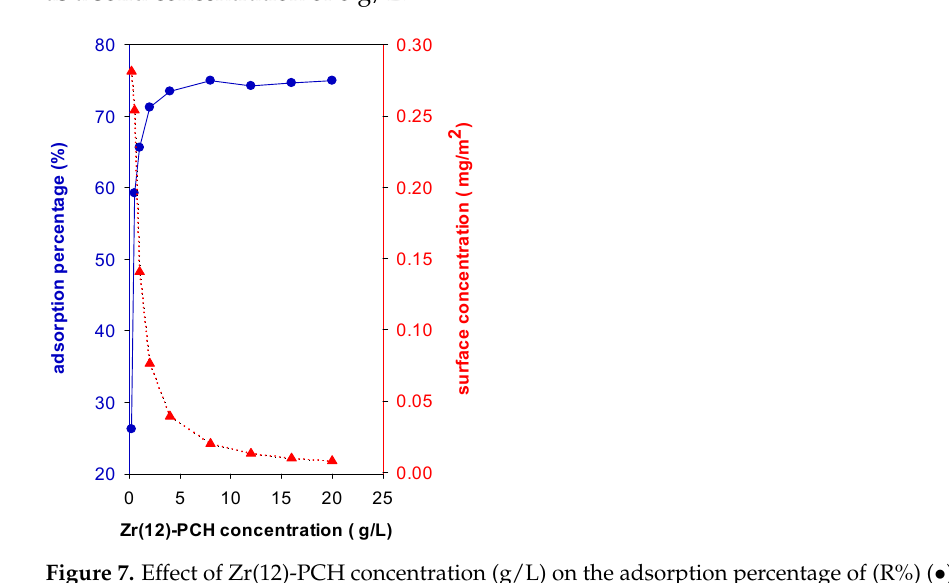
ed c Figure 6. Effect of Zr contents in the Zr(X) ‐ PCH materials on the adsorbed amounts of BB ‐ 41 dye. (a) Zr(0) ‐ PCH, (b) Zr(3) ‐ PCH, (c) Zr(6) ‐ PCH, (d) Zr(12) ‐ PCH, and (e) Zr(24) ‐ PCH.